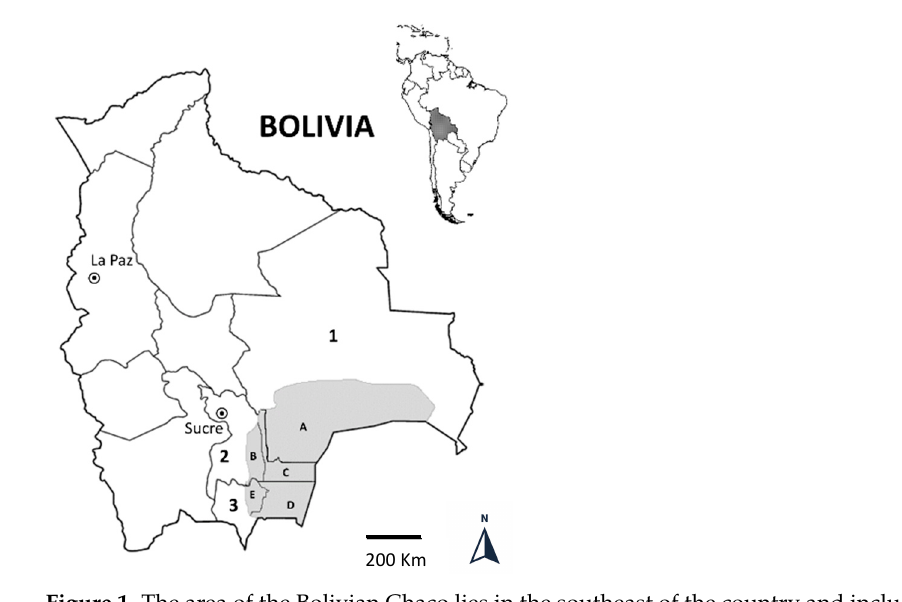
Figure 1. The area of the Bolivian Chaco lies in the southeast of the country and includes 3 departments (numbers on the map: Santa Cruz = 1; Chuquisaca = 2; Tarija = 3) and 5 Provinces (letters on the map: Cordillera = A; Hernando Siles = B; Luis Calvo = C; Gran Chaco = D; O’Connor = E).